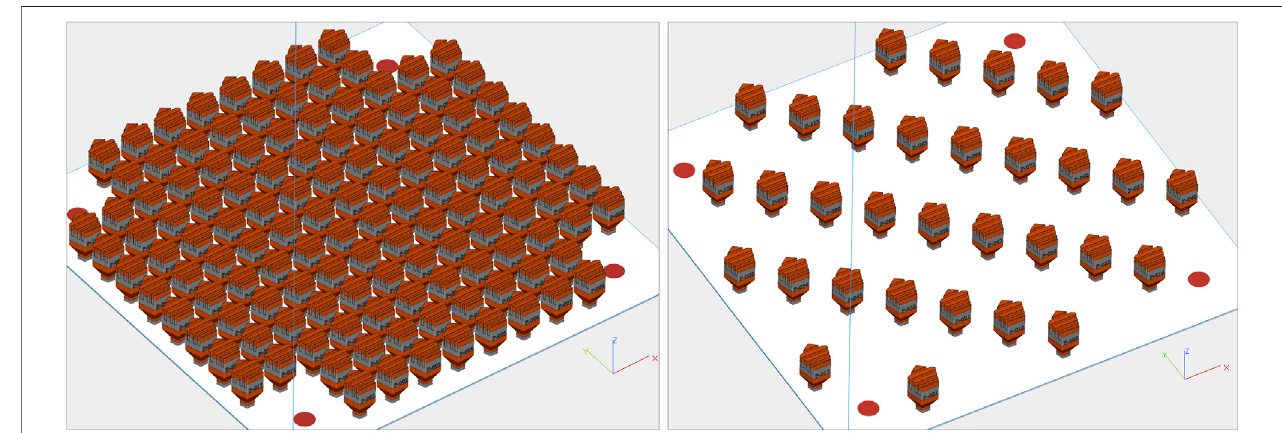
FIGURE1| Left:geometryforbuild1.Right:geometryforbuilds2,3,and4.Forbuilds1and2thegrayandredregionsrepresentwherelasermodules1and2are used respectively.